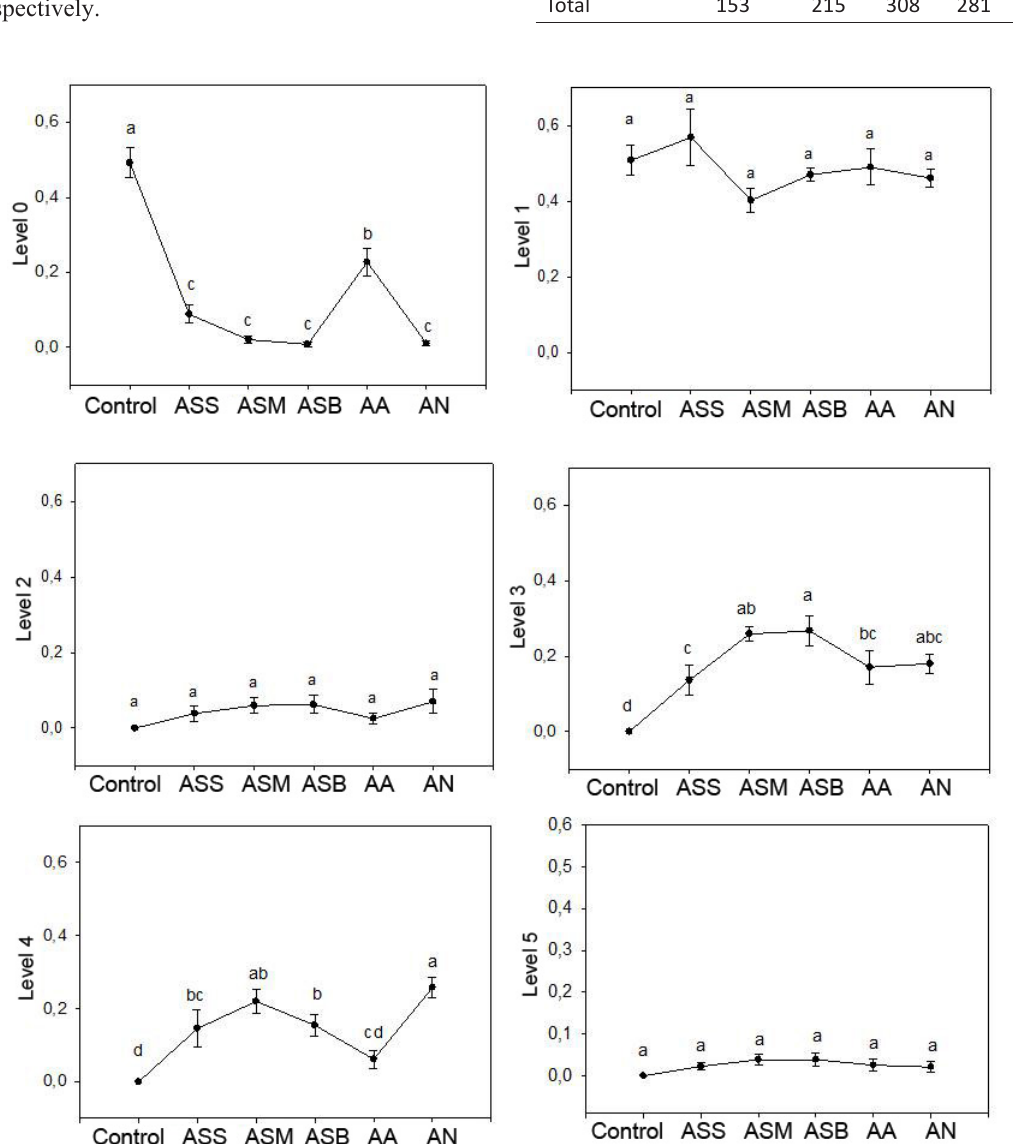
Fig 2. Average ratio of six aggression levels (0-5) in six treatments: conspecific nestmate workers (Control); conspecific from colony collected in the field (ASS), workers of A. subterraneus molestans (ASM), A. subterraneus brunneus (ASB), queens of A. ameliae (AA) or workers of A. niger (AN) with their standard errors. Different letters indicate significant differences by post hoc Fisher test